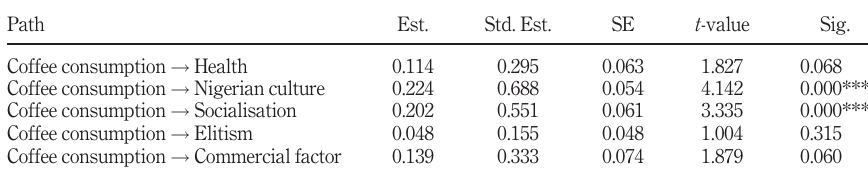
Table 4. Path model results